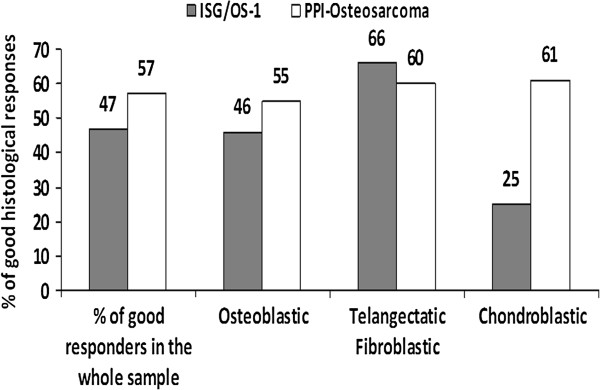
Incidence of GR in eligible patients (PPI-Osteosarcoma) versus the comparator group (ISG/OS-1). Comparison among the groups by means of Fisher’s exact test: Osteoblastic p = 0.32, Fibroblastic + Telangectatic 0.70, Chondroblastic p = 0.07.